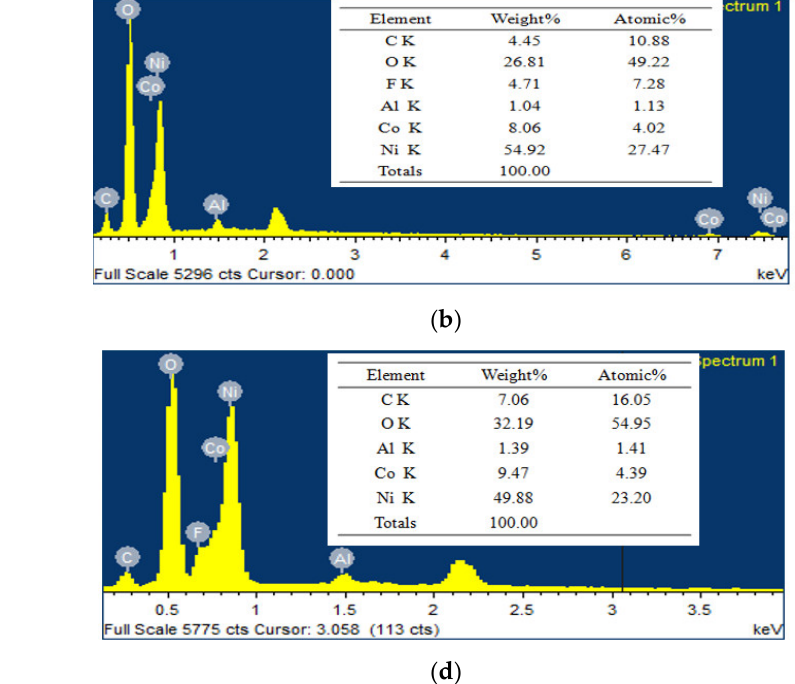
Figure 6. SEM images and EDS pattern of cathode active material: ( a , b ) uncalcined and ( c , d ) calcined at 700 °C.